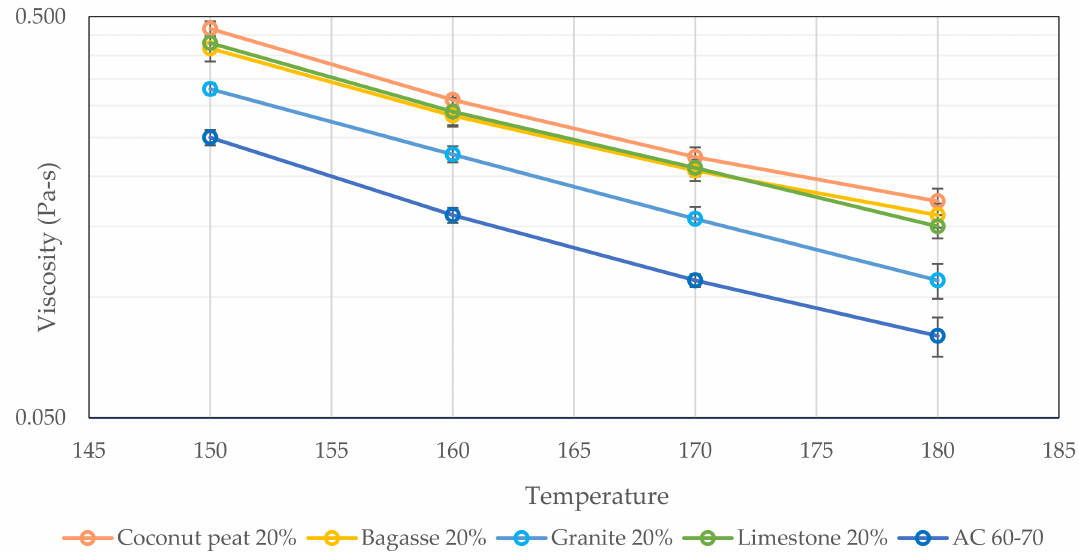
Figure 5. The viscosities of asphalt binder and asphalt mastics at 20 rpm with di ff erent temperatures.